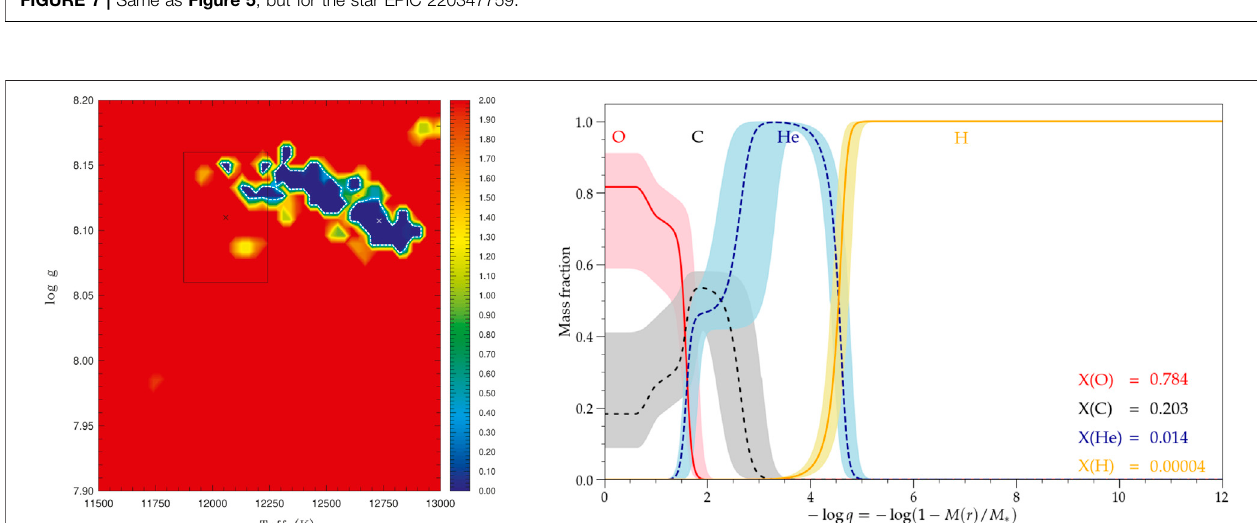
FIGURE 8 | Same as Figure 5 , but for the star L19-2. The core structure is less tightly constrained in this case which correlates to the degeneracy of the solution seen in the log g − T eff map, while the thickness of the H-rich envelope is still well determined.